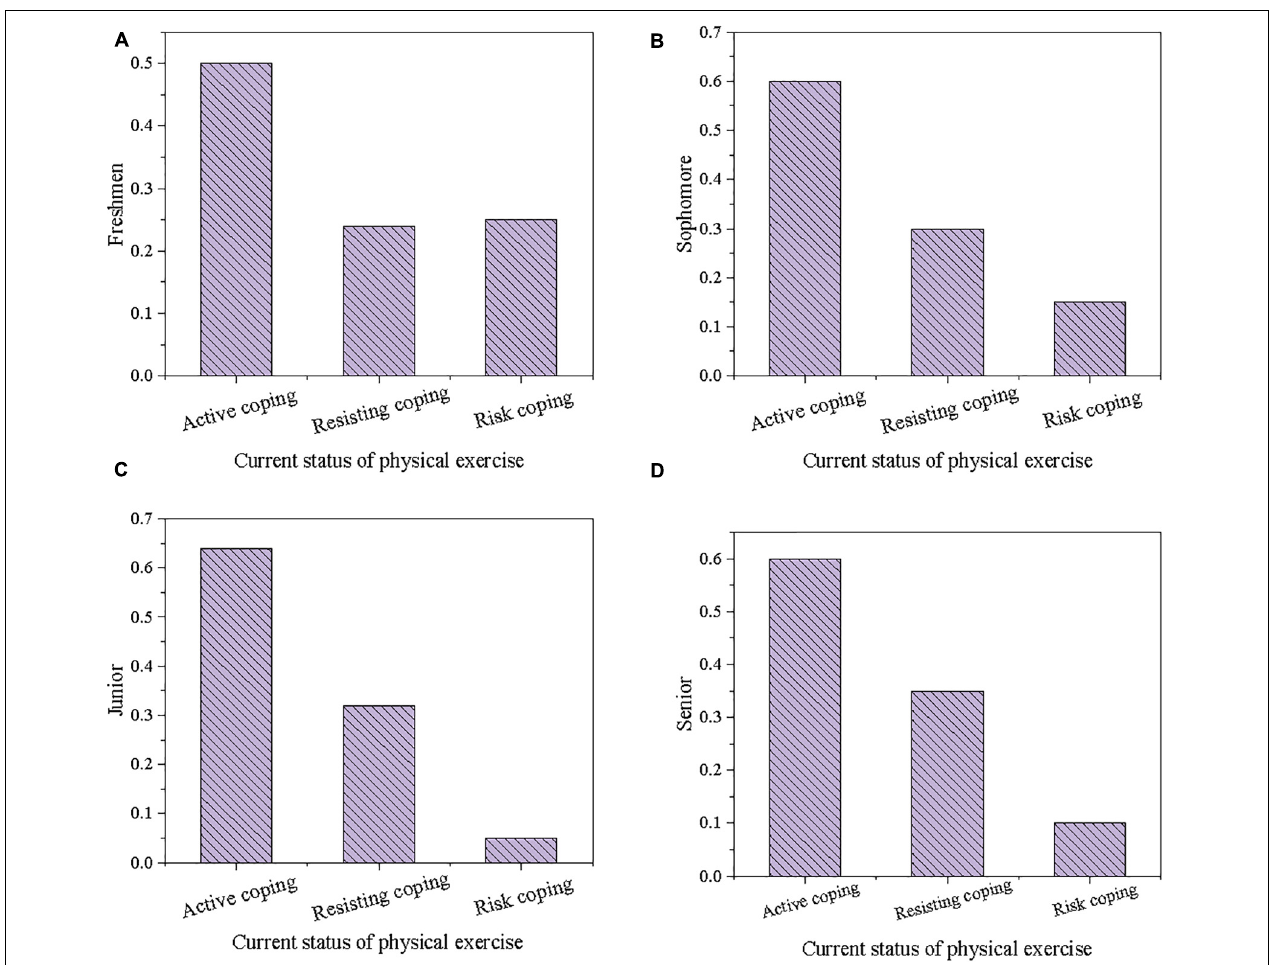
FIGURE 4 | Comparison results of different grades of coping attitudes of college students toward physical exercise. ( A : Freshmen; B : Sophomore; C : Junior; D : Senior).